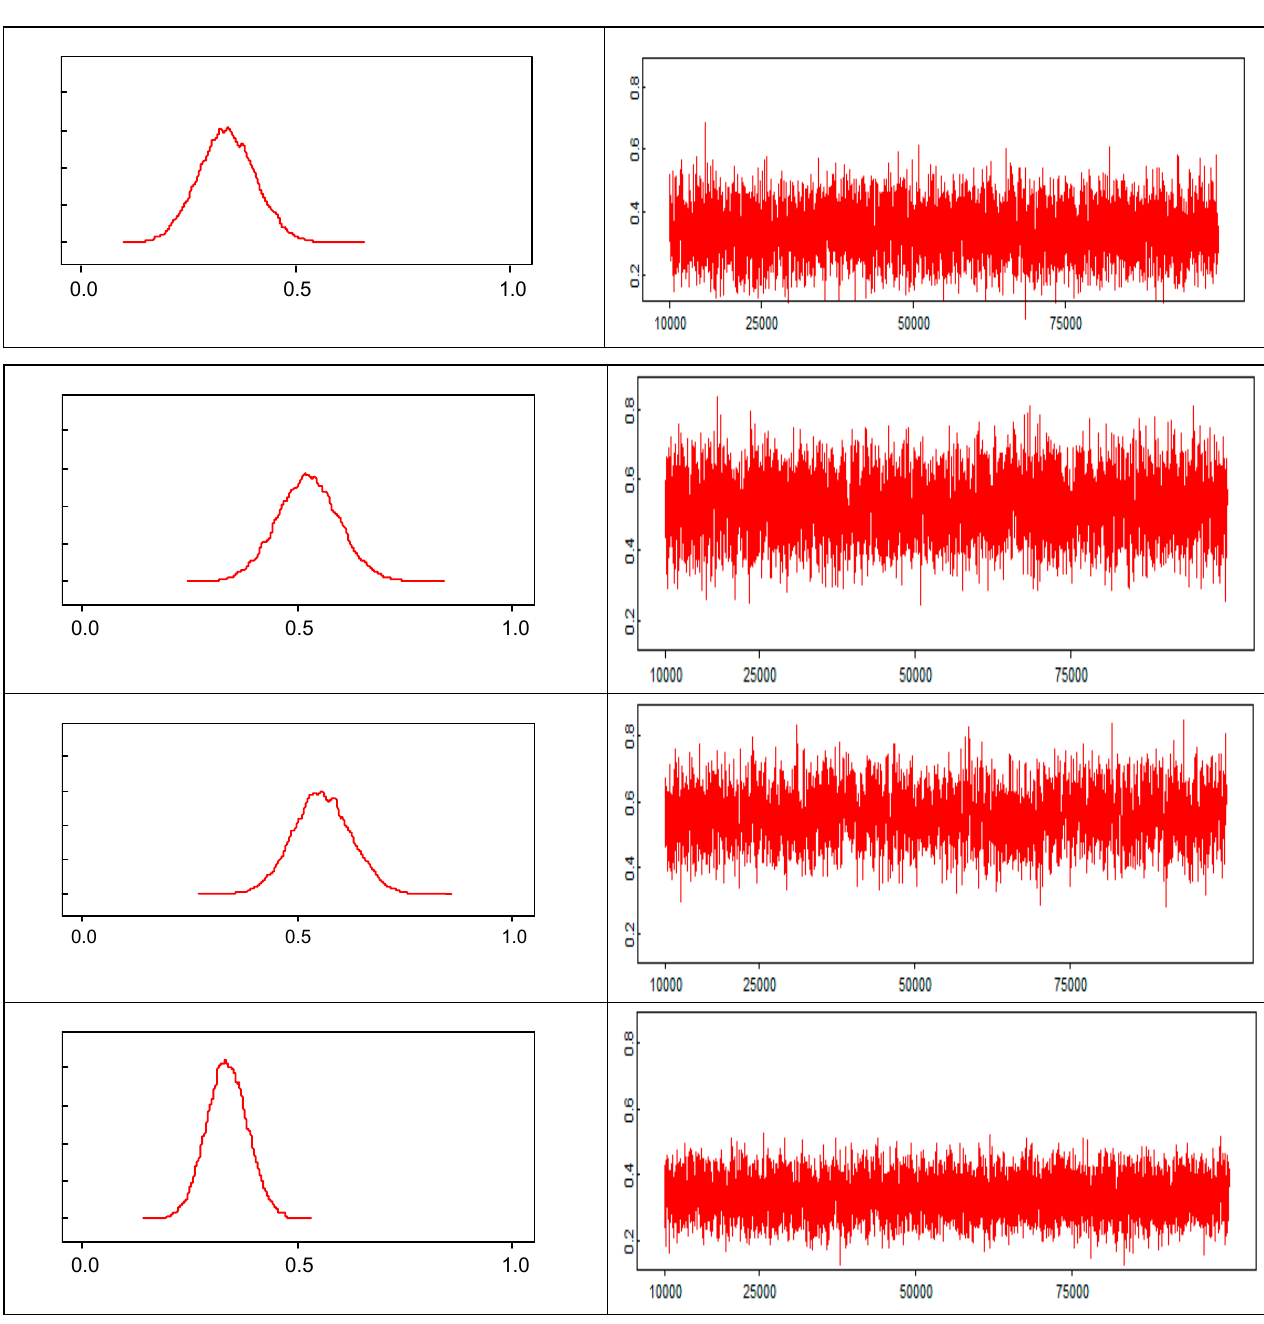
Figure 3. MCMC marginal posterior densities ( left ) and traceplots before thinning ( right ) for the parameters driving the hypothesized latent associations (beta1 = H1 in the top row through beta4 = H4 in the bottom row).